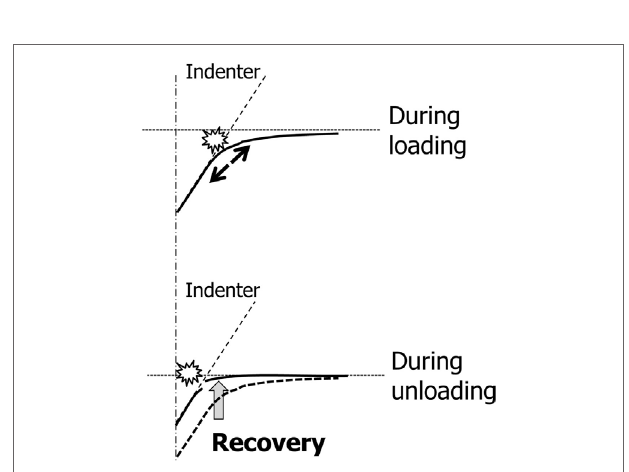
FigUre 10 | schematic drawings of edge crack appearance during both loading and unloading .